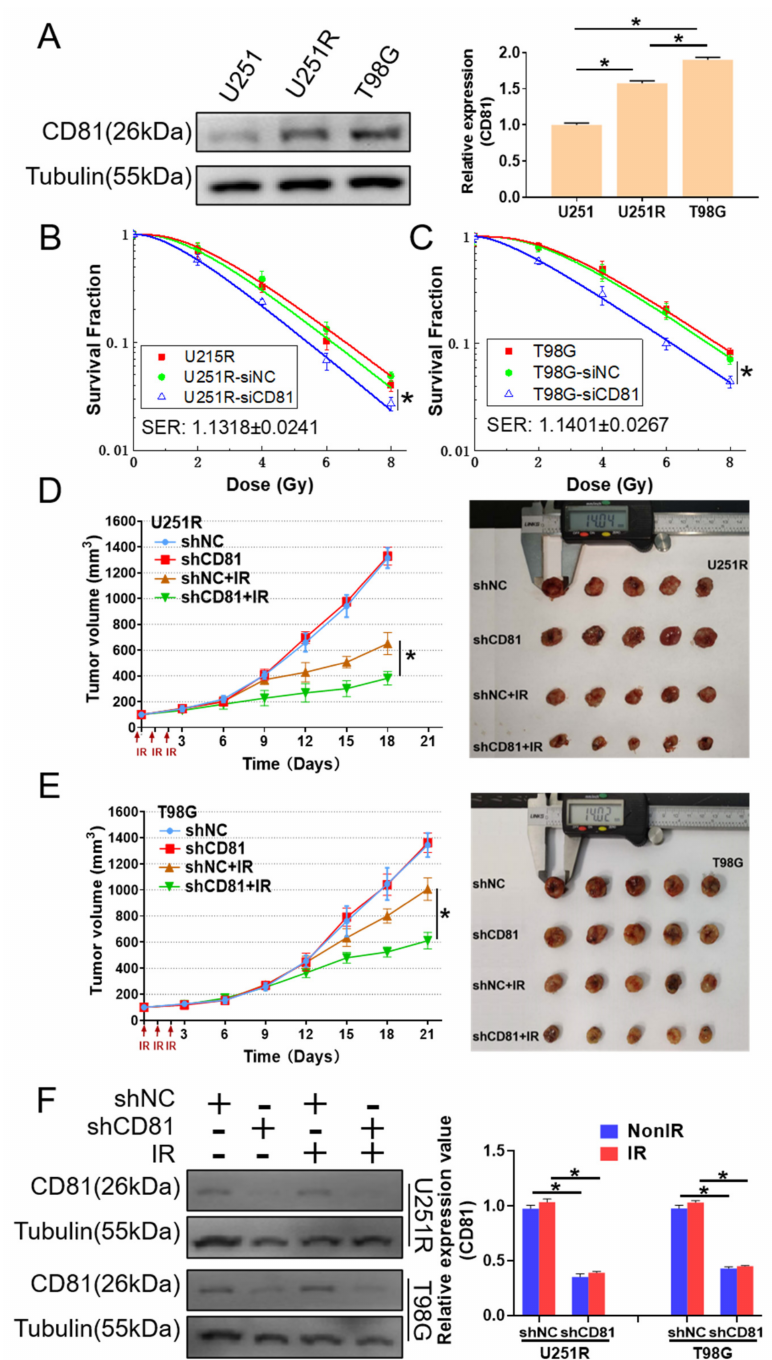
Figure 2. Inhibition of CD81 enhanced radiosensitivity of GBM cells in vitro and in vivo. ( A ) Western blot analysis ( left ) and quantitation ( right ) of CD81 expression level in U251, U251R, and T98G cells. Tubulin was used as a loading control. ( B , C ) Clonogenic survivals of U251R cells ( B ) and T98G ( C ) cells transfected with siCD81 or siNC after X-ray irradiation. Sensitizer enhancement ratio (SER) was calculated with OriginLab software. ( D , E ) Growth curves of the xenograft tumors of U251R ( D ) and T98G ( E ) cells transfected with shCD81 or shNC with or without 3 × 8 Gy fractionated X-ray irradiation. Tumor volume was measured every three days with a digital caliper and calculated using the formula (L × W 2 ) × π /6. Images of the dissected tumors from athymic nude mice ( n = 5) were also shown. ( F ) Western blot analysis (left) and quantitation (right) of CD81 expression level in dissected tumors above. *, p < 0.05 between indicated